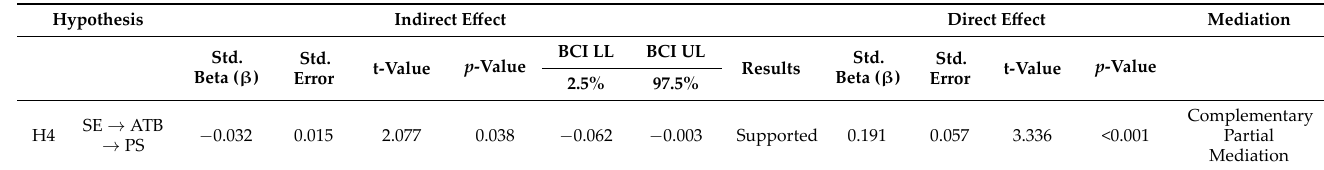
Table 6. Mediation Testing.